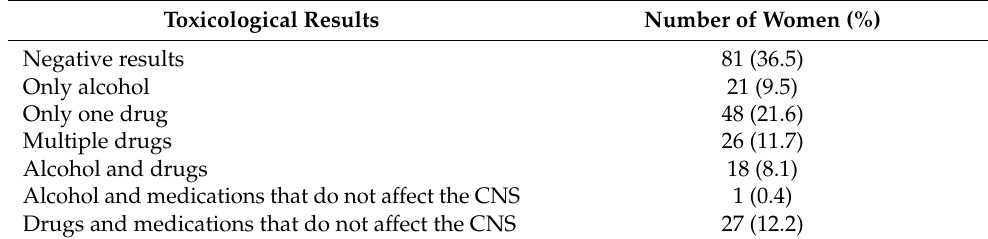
Table 5. Results of the toxicological analysis.